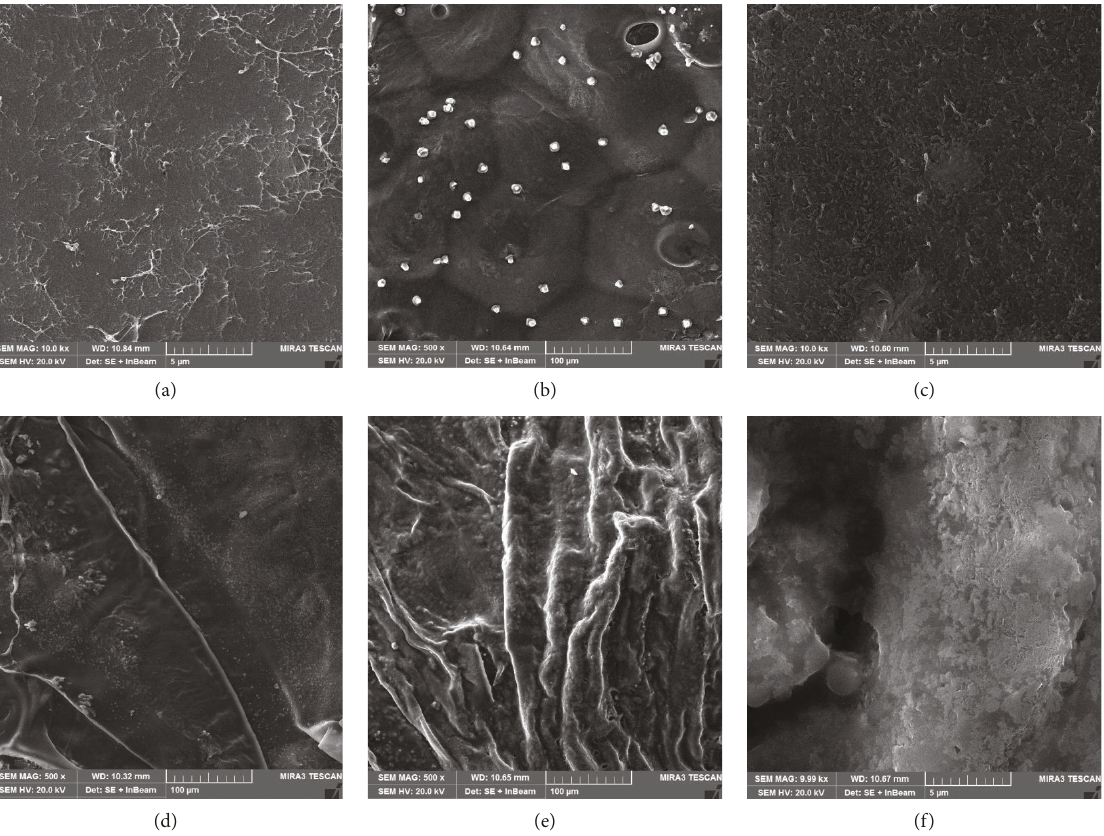
Figure 3: Surface morphology of the prepared membranes. (a) Simple chitosan (5 μ m), (b) simple chitosan composite (low resolution, 100 μ m), (c) simple chitosan composite (high resolution, 5 μ m), (d) porous chitosan (100 μ m), (e) porous chitosan composite (low resolution, 100 μ m), and (f) porous chitosan composite (high resolution, 5 μ